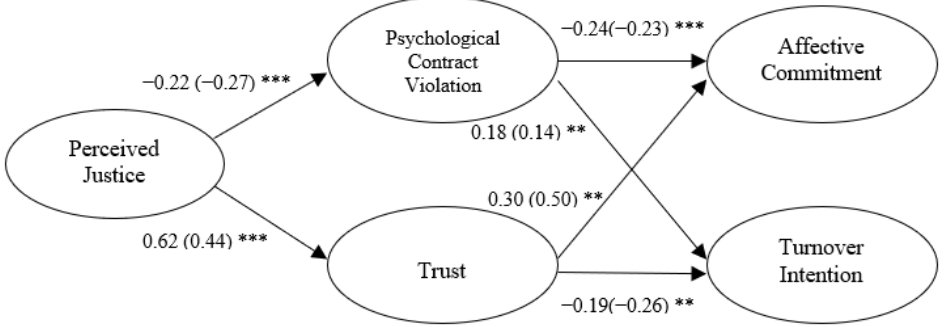
Figure 2. Hypothesis testing results. Notes: ** p < 0.01, *** p < 0.001. Unstandardized path coefficients are shown in parentheses.